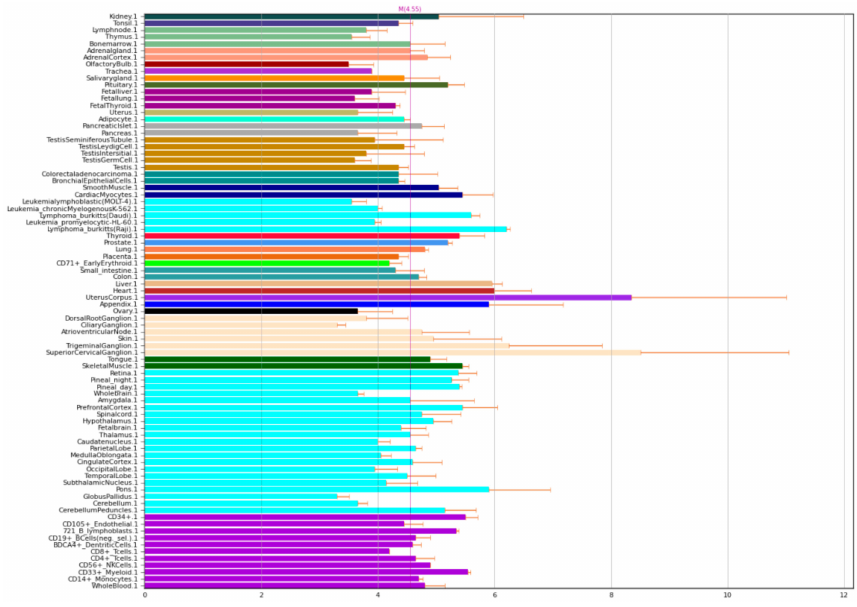
Figure 1. Expression of NOS1 in the human body [4,5].